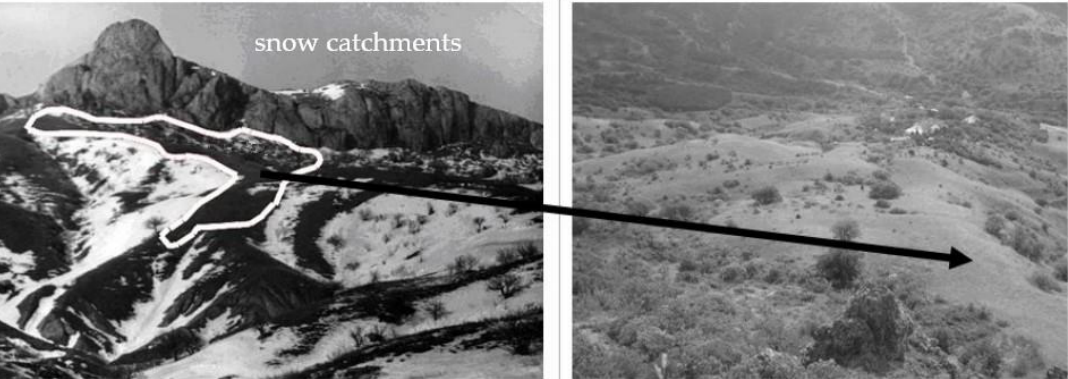
Figure 6. Snow-covered slopes of the south-southwest exposure of the gully on the eastern slope of the Besh-Tash ridge